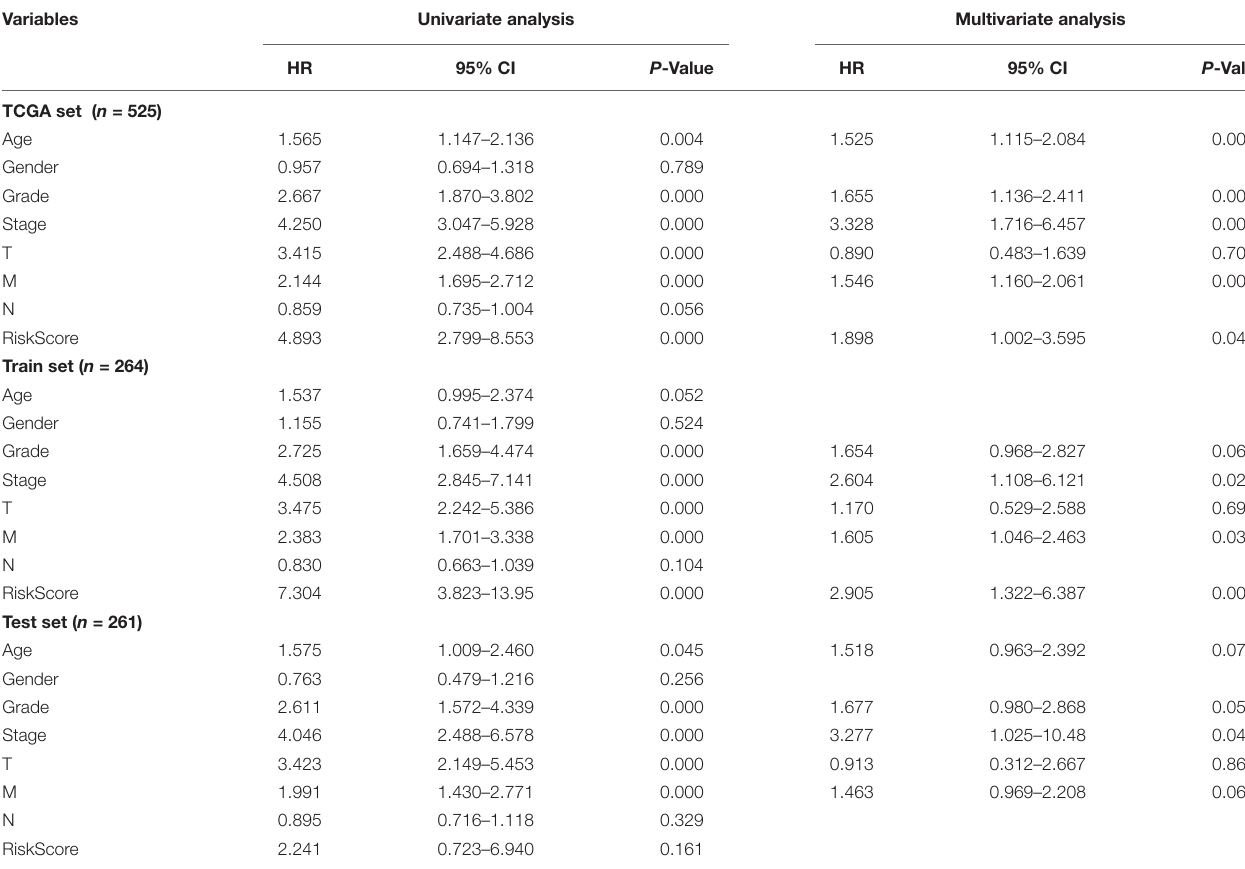
TABLE 2 | Univariate and Multivariate cox regression analysis of the GILncSig and overall survival in different patient sets. Variables Univariate analysis Multivariate